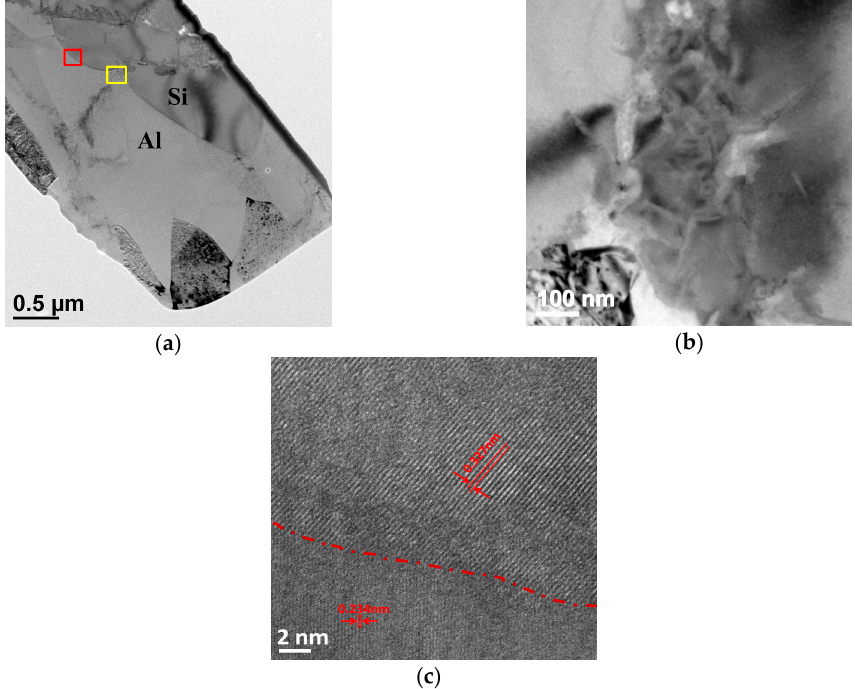
Figure 7. TEM micrographs of the Si/Al interface of the PM-8p-ECAP composite: ( a ) low magnification, ( b ) high magnification of Region A (yellow square in ( a )) and ( c ) Region B (red square in ( a )).